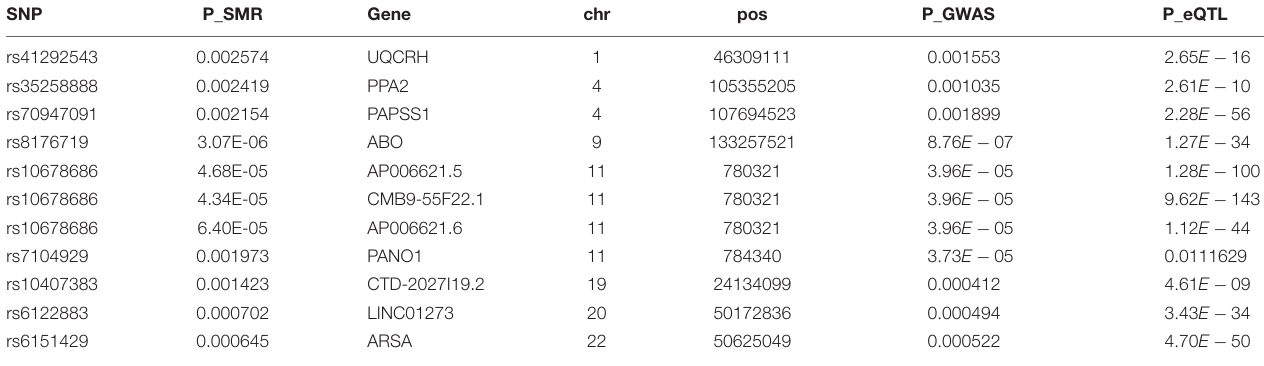
FIGURE 5 | The experimental results based on SMR. TABLE 1 | Nine Causal SNPs and eleven pathogenic genes of